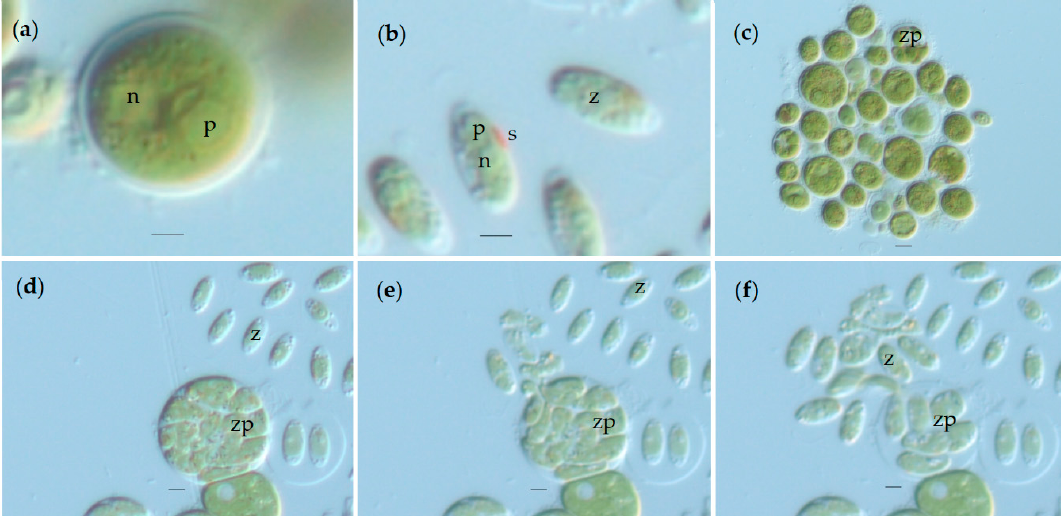
Figure 2. Microscopic images of Chlorococcum amblystomatis life stages using the differential interference contrast (DIC): ( a ) vegetative cell; ( b ) zoospore; ( c ) group of cells with indefinite form; ( d ) zoosporangium; ( e ) and ( f ) burst of zoosporangium membrane and realizing of zoospores. n = nucleus, p = pyrenoid, s = stigma, z = zoospore, zp = zoosporangium. Scale bar ( a ) and ( b ) = 2 µm, ( c ) to ( f ) = 5 µm.